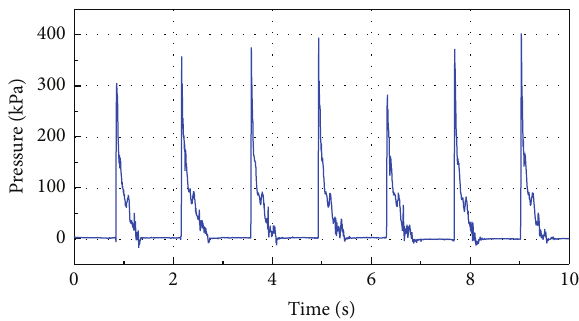
Figure 11: Time history of slamming pressure at sensor number 1 (scheme